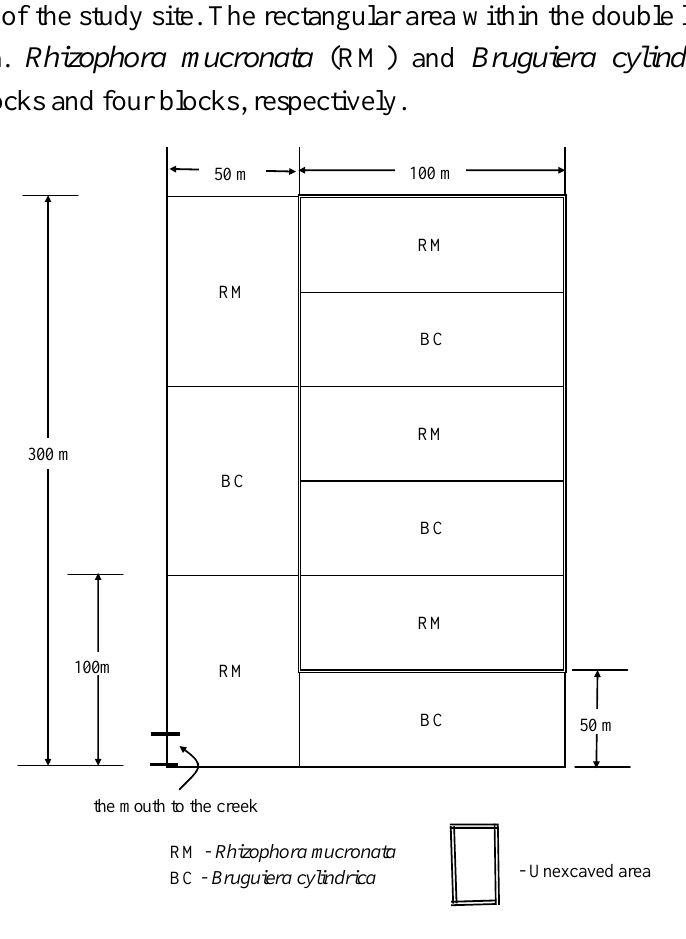
Figure 5. Water inundation duration (in hours) throughout 2007 in the unexcavated and the excavated